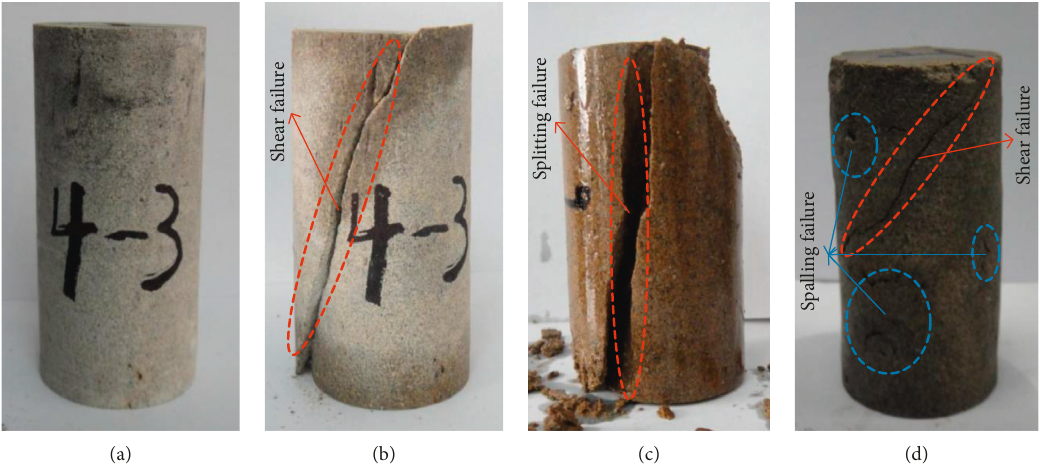
Figure 7: Typical test results of rock. (a) Rock samples. (b) Conventional triaxial compression failure mode. (c) Uniaxial compression failure mode. (d) Triaxial compression failure mode with unloading confining pressure.